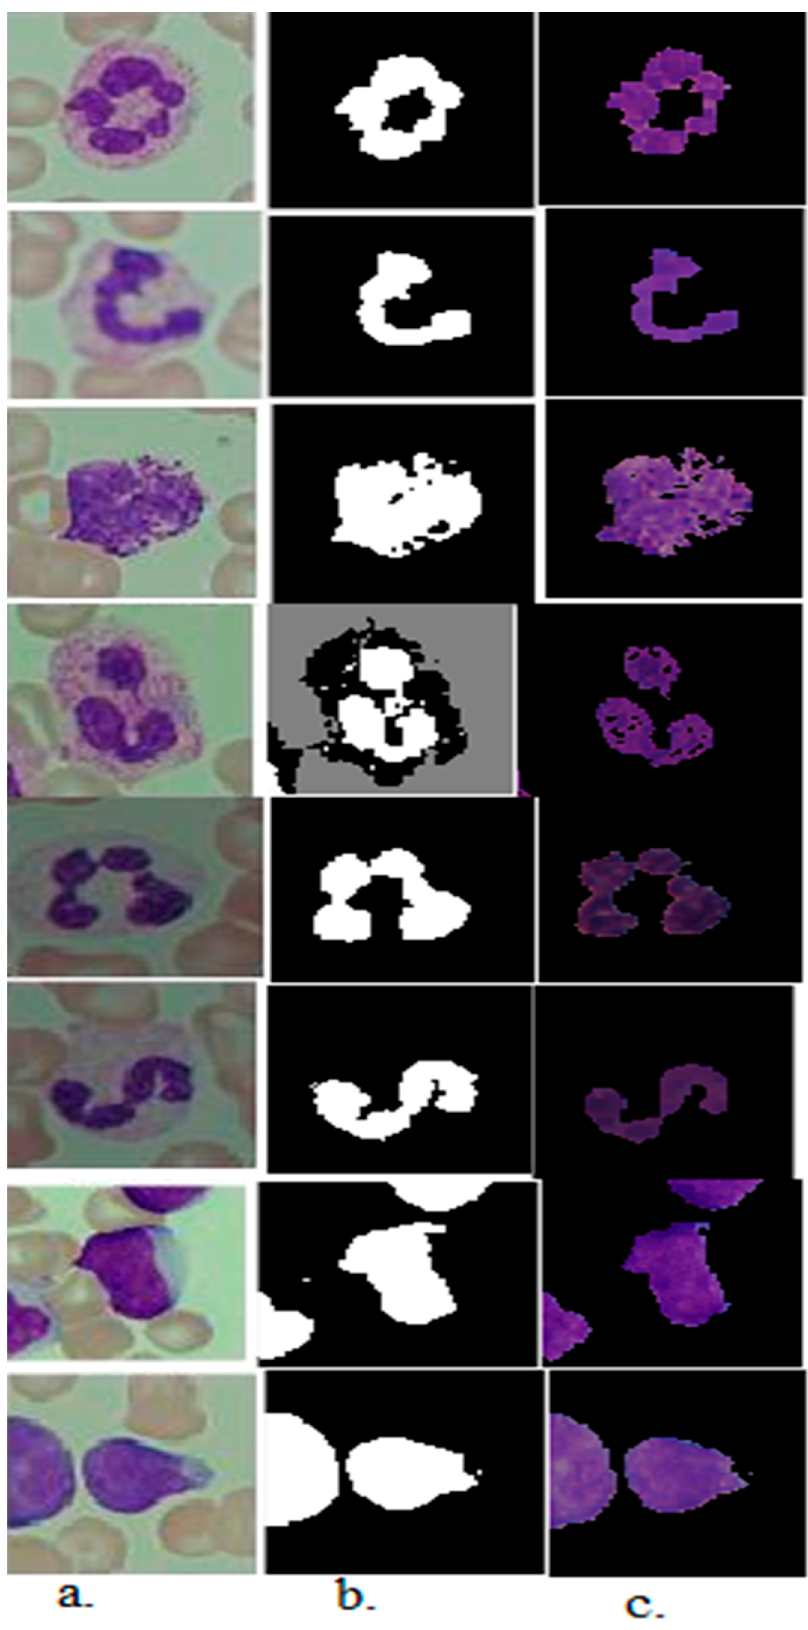
Figure 4. A set of samples from the acute leukemia dataset. After enhancement. ( a ) Original images ( b ) Segmentation of WBC cells. ( c ) Region of interest (WBC cells).